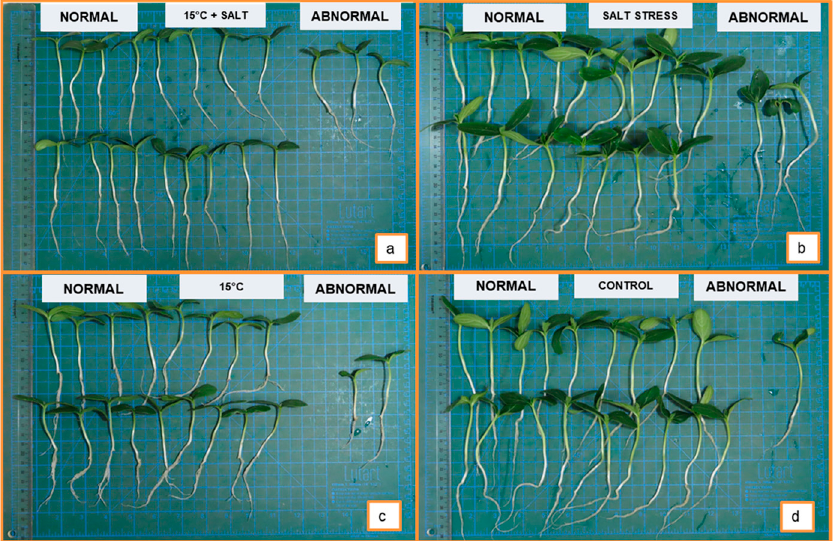
Figure 2. ( a ): normal and abnormal seedlings at 15 °C +salt, ( b ): normal and abnormal seedlings at salt, ( c ): normal and abnormal seedlings at 15 °C, ( d ): normal and abnormal seedlings at control.